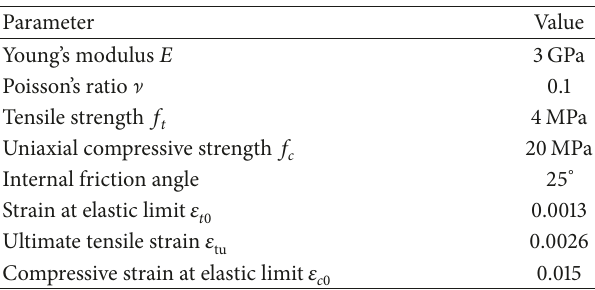
Table 1: COx clay